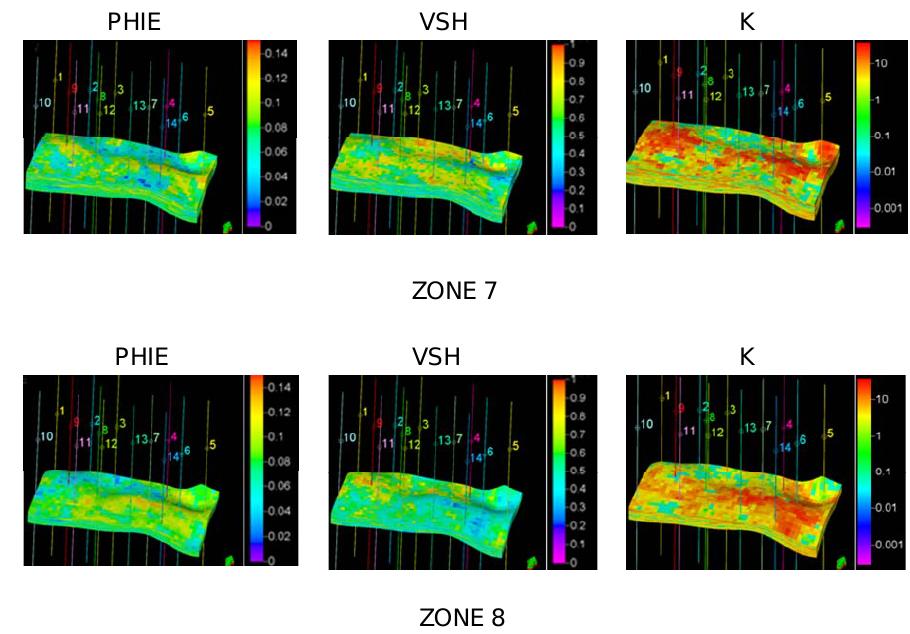
Fig. 10. Fractal distributions of effective porosity (PHIE), shale volume (VSH) and permeability (K) for zones 7 and 8.